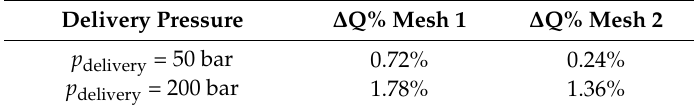
Table 2. Mesh sensitivity varying the mesh size in the boundary layers, simulations at 1500 rpm.